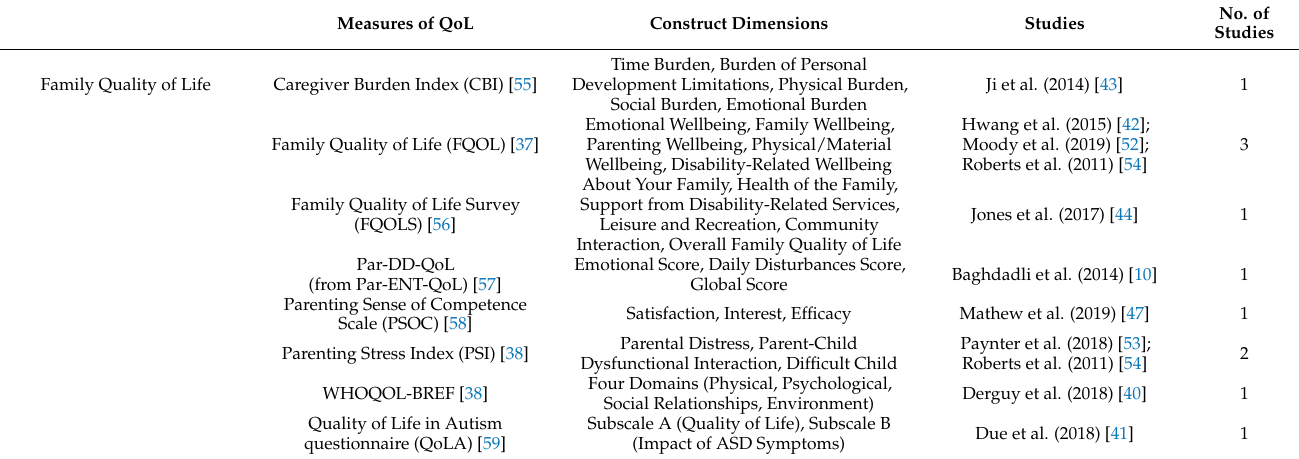
Table 2. Measurement instruments and construct dimensions listed in the included studies ( n =